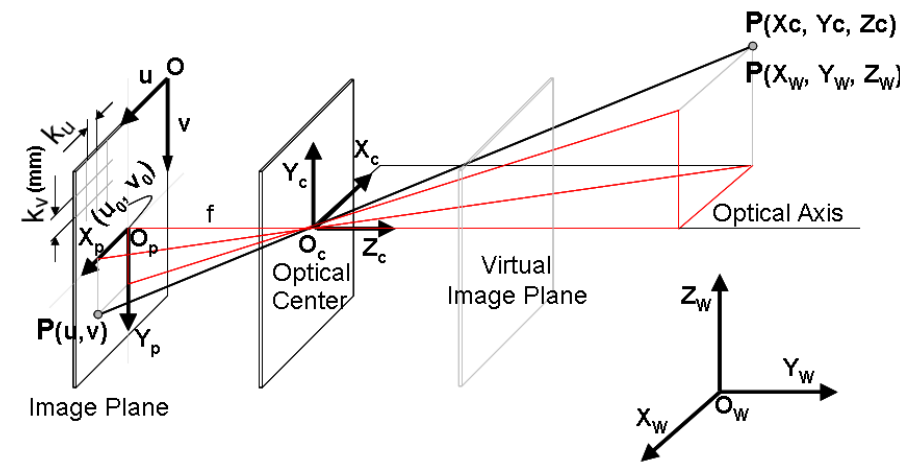
Figure 4. Perspective projection of pin-hole camera model without distortion